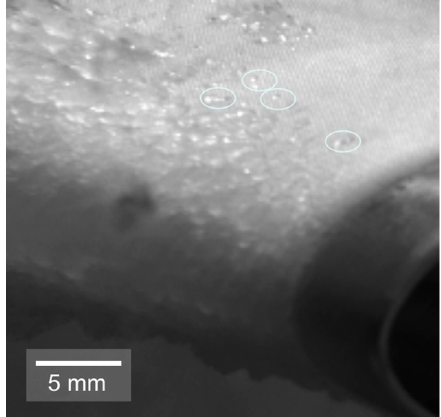
Figure A3. Ice formation on the fabric mounted on a NACA 0012 airfoil showing isolated feathery ice grains near the top side (circled) that become more dense and homogenous approaching the stagnation line.